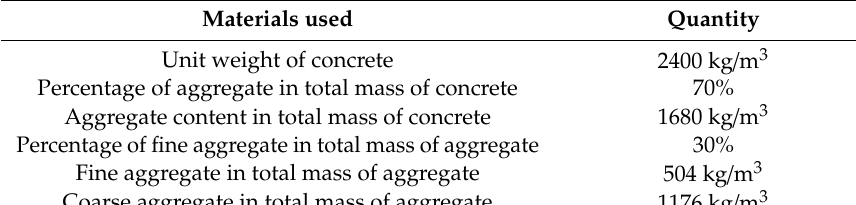
Table 5. Mix design of di ff erent materials per cubic meter (6 M NaOH).